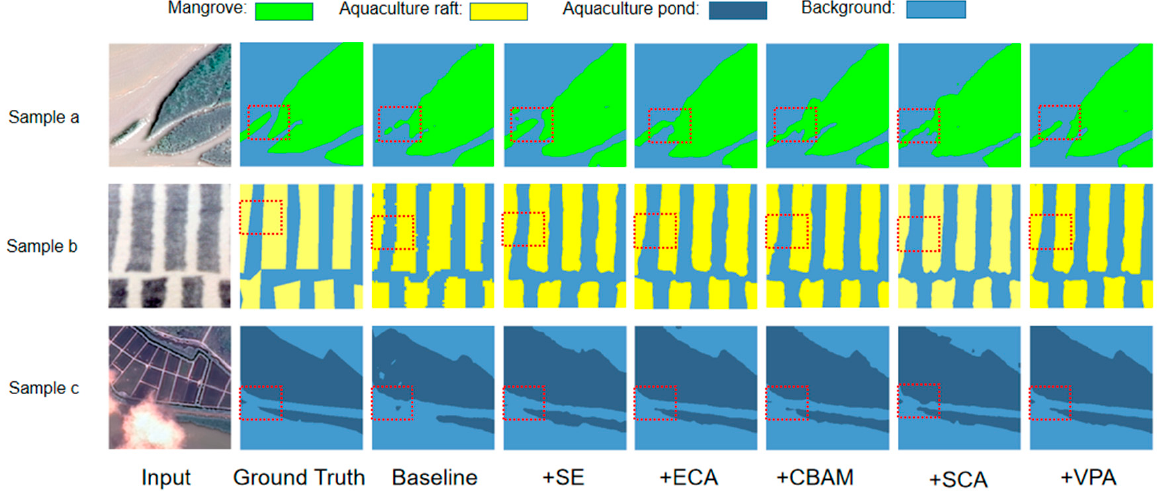
Figure 7. Comparison of prediction samples on the MO-CSSSD. The red dashed lines mark the more obvious differences.